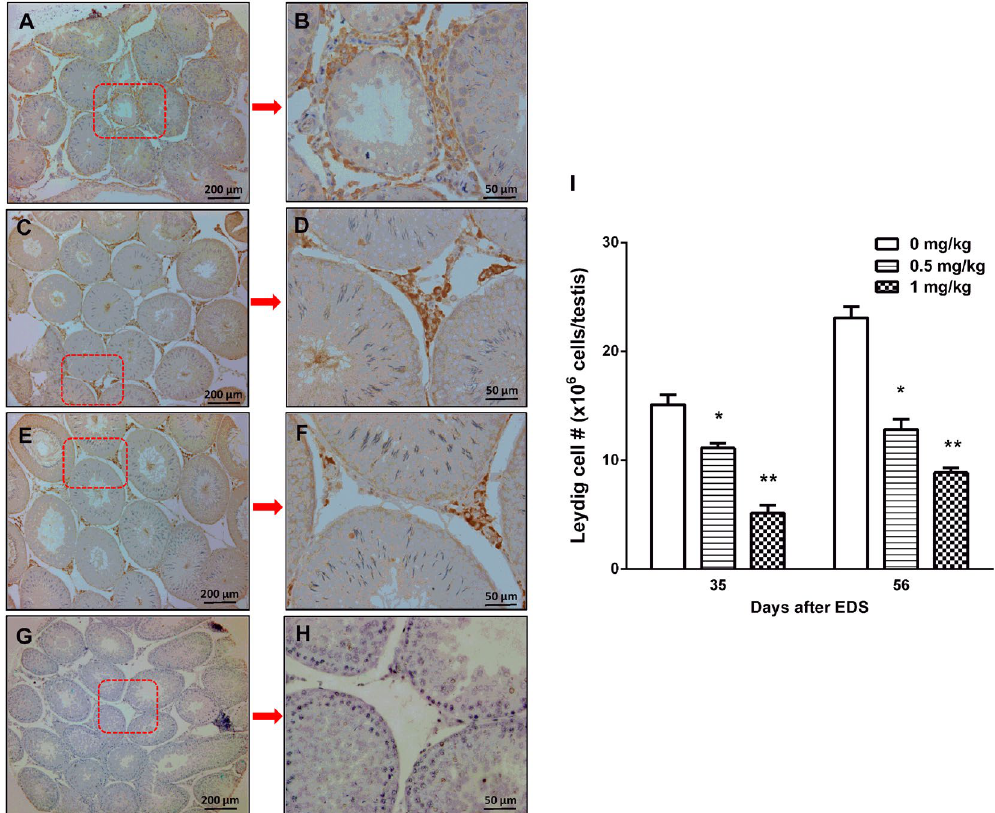
on days 35 and 56 after EDS treatment. ( A ) and ( B ) for control group on days 35 and 56; ( C ) and ( D ) for 0.5 mg/ kg CdCl on days 35 and 56; ( E ) and ( F ) for 1.0 mg/kg CdCl on days 35 and 56; ( G ) and ( H ) for the negative control. ( I ) Quantification of 3 β -HSD1 positive Leydig cell numbers on days 35 and 56. Mean ± SE, n = 5. * P < 0.05, ** P < 0.01 indicate significant difference when compared to control (CON) at each time